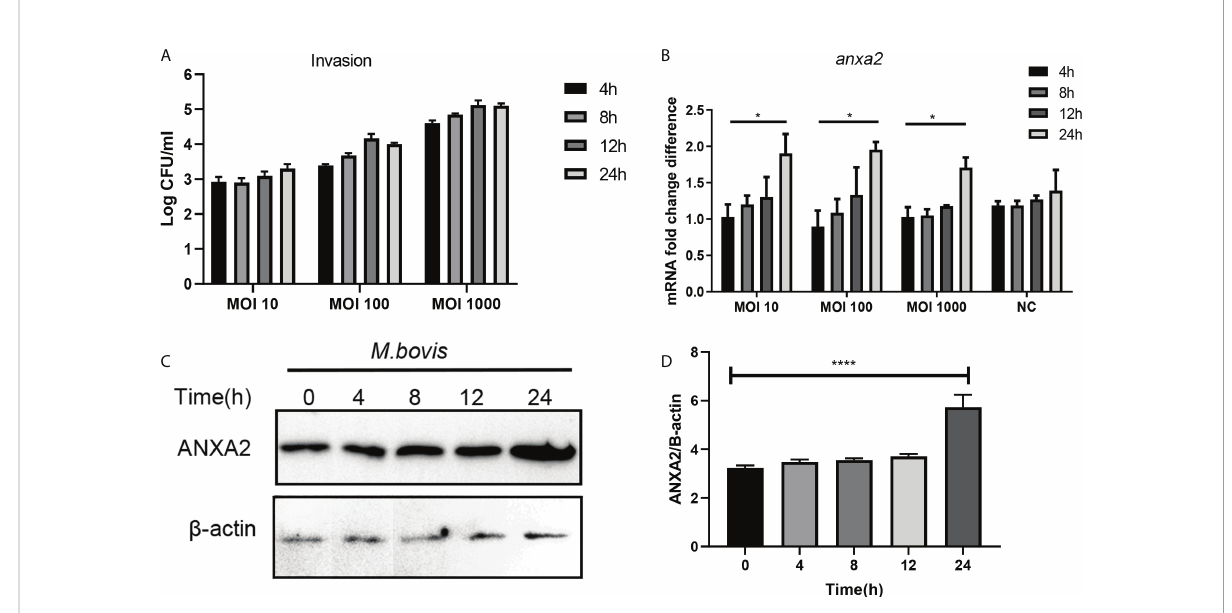
FIGURE 1 M. bovis infection increased the ANXA2 expression in EBL cells. (A) The number of invaded M. bovis in EBL cells at different infection time points and MOI. (B) The mRNA levels of AnxA2 gene in EBL cells infected with M. bovis at different MOI and infection time. (C) Expected AnxA2 protein bands at different time points of M. bovis infection. (D) Image J software analyzed band intensity of ANXA2 protein in (C) . Data represent means ± SD. * p < 0.05, **** p <